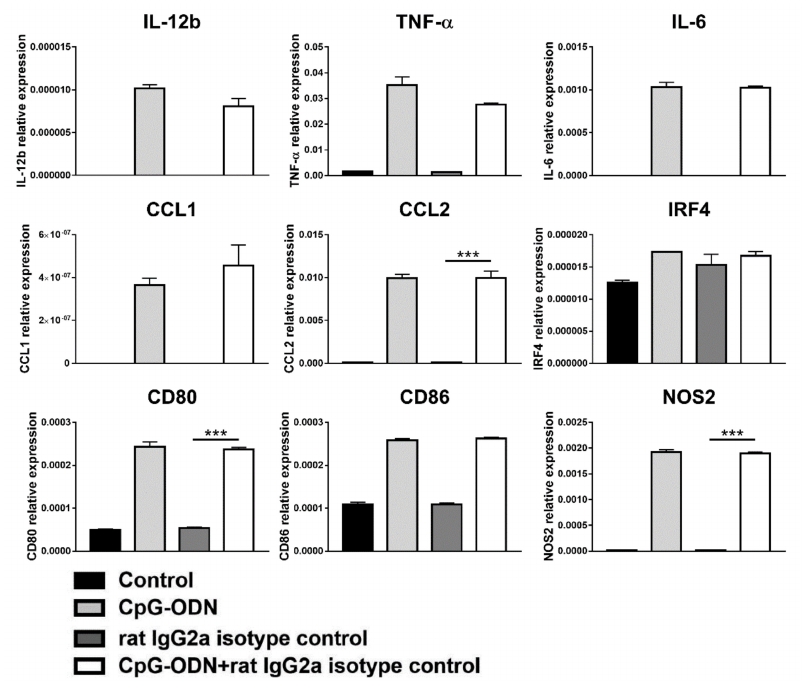
Figure 8. Effect of the combination of CpG-ODNs and rat IgG2a isotype control antibody on RAW264.7 macrophages in vitro. RAW264.7 macrophages were seeded in 12-well plates and then stimulated with 1 µ M CpG-ODN and 10 µ g/mL rat IgG2a isotype control antibody alone or in combination for 6 h. Controls were left untreated. At the end of treatment, mRNA was extracted, and real-time PCR was performed. The data were normalized to the expression of β 2m as a housekeeping reference gene and analyzed by the comparative 2 − ∆ Ct method. The data are presented as the mean ± SEM and were analyzed by one-way ANOVA followed by Tukey’s multiple comparison test with a single pooled variance or by the Kruskal–Wallis test followed by Dunn’s multiple comparison test for nonparametric data. *** p < 0.001. CpG-ODNs: CpG oligodeoxynucleotides; anti-PD-1 Ab: anti-PD-1